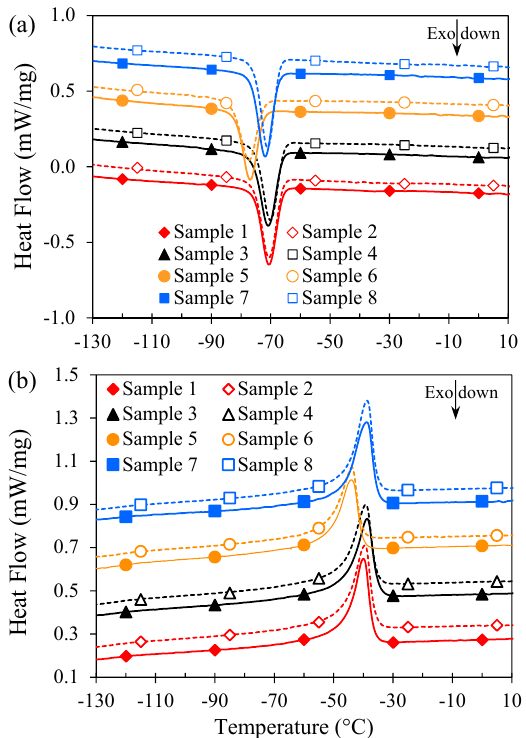
Figure 8. Comparative DSC thermograms of SR samples in the ( a ) second cooling cycle and ( b ) second heating cycle.